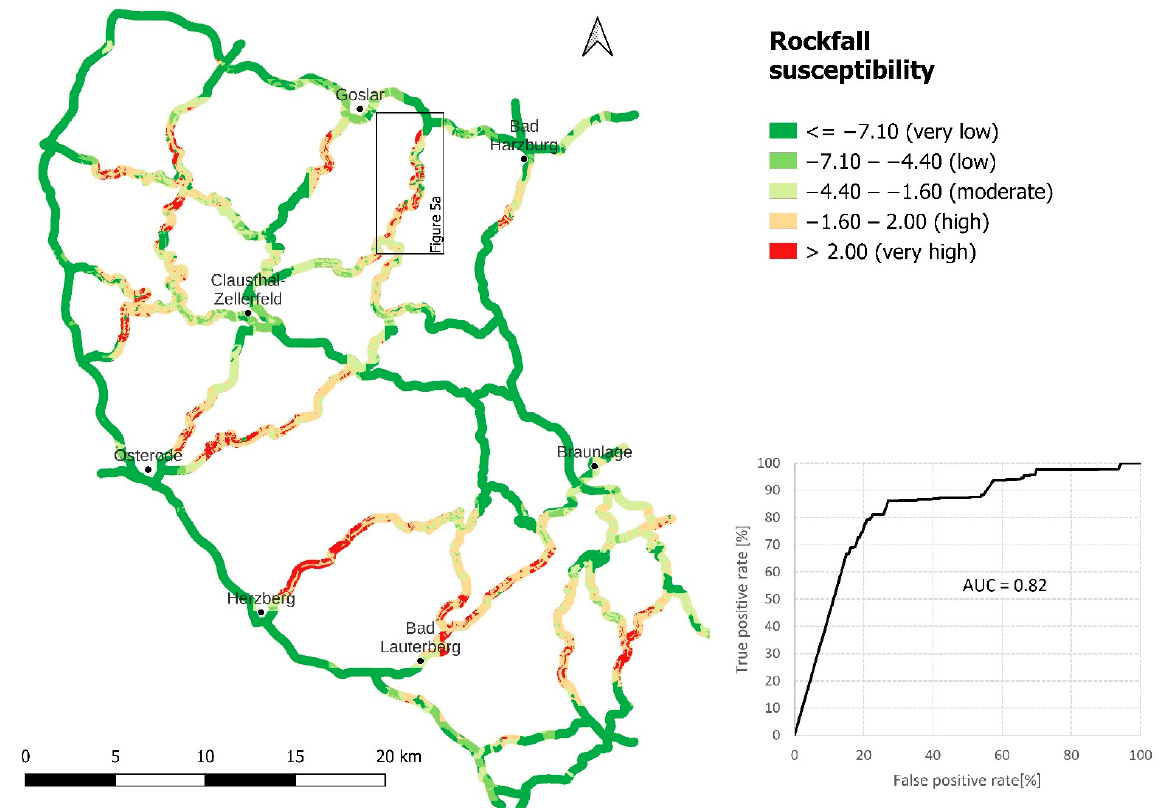
Figure 6. Landslide susceptibility model and model validation for corridors of the Harz mountains road network using an information value. For better visibility, the road corridor is displayed with 500 m width. For modeling, a 100 m corridor was applied. Model validation resulted in an AUC of 0.83.